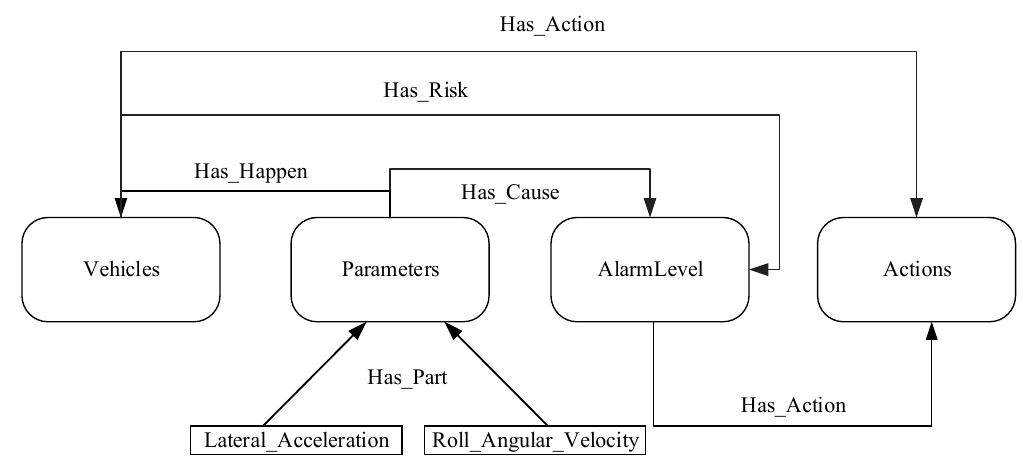
Figure 3. Object properties’ relationships in the ontology model.